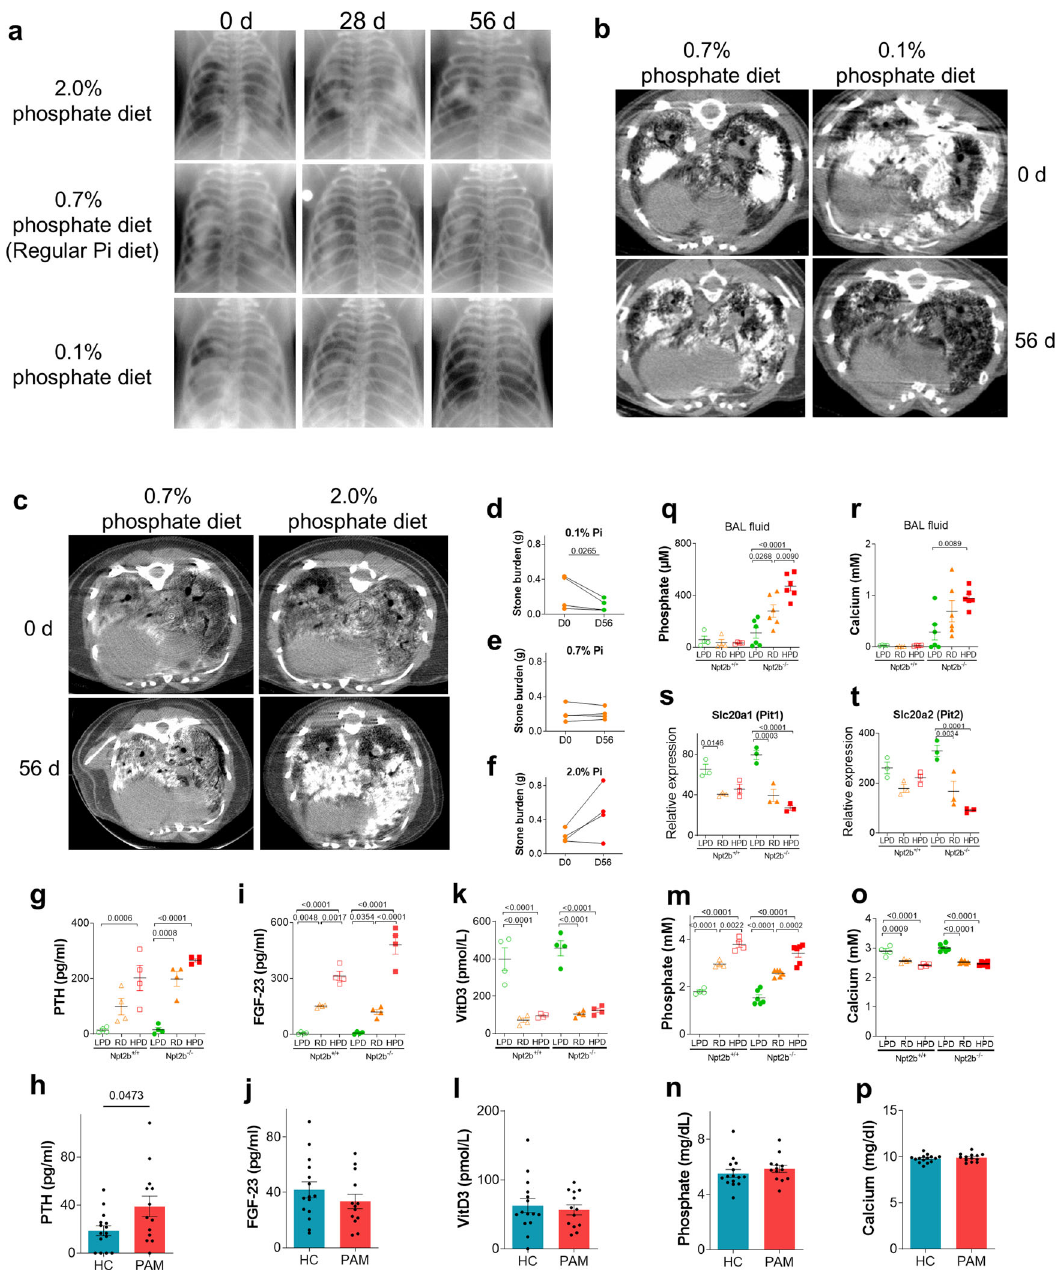
Fig. 6 | Dietary phosphate modulates phosphate homeostasis and stone accumulationinNpt2b − / − mice.a – f Twenty-to28-week-oldNpt2b − / − mice( a , b )or 5to6-week-oldNpt2b − / − mice( c )werefedwithlow(0.1%)(LPD),regular(0.7%)(RD) or high (2%) phosphate diet (HPD) for 8 weeksasindicated. a Serialradiographs of individual Npt2b − / − mice after 0, 28 and 56 days on the indicated phosphate diet. b Serial microCT images of individual Npt2b − / − mice before and after 56d on RD (0.7% phosphate (Pi)) and LPD (0.1% Pi) diet. c MicroCT images of Npt2b − / −